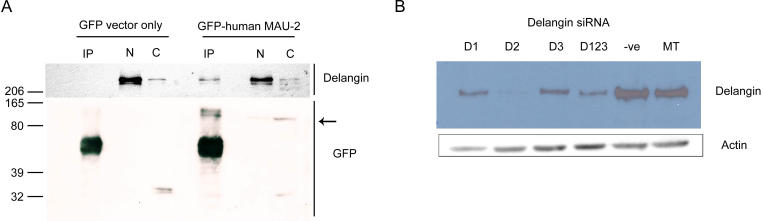
Co-Immunoprecipitation Studies Support Interaction between Delangin and Human MAU-2(A) Delangin co-immunoprecipitates with a GFP-human MAU-2 fusion protein. HeLa cells were transiently transfected with a GFP-human MAU-2 fusion protein construct (see
Materials and Methods) or, as a negative control, with the GFP vector on its own. Cells were fractionated into nuclear (N) and cytoplasmic (C) fractions, and aliquots of the nuclear fractions were used for immunoprecipitation with an anti-GFP antibody to generate immunoprecipitation fractions. Individual fractions were size fractionated by SDS-PAGE and immunoblotted, using antibodies against delangin (top panel) or against GFP (bottom panel) as described in
Materials and Methods. The immunoprecipitation fraction from immunoprecipitating the GFP-human MAU-2 fusion protein reveals a specific band at ˜100 kDa (arrow) that is not found in the negative control sample. This is the size expected for the fusion protein (˜70 kDa for human MAU-2 and ˜ 30 kDa for GFP). The upper panel shows that the delangin antibodies identify a band of ˜ 300 kDa that is co-precipitated in the GFP-human MAU-2 immunoprecipitation sample but not in the GFP vector-only control sample.
(B) Delangin siRNA. In order to validate the specificity of the monoclonal antibody to delangin, HeLa cells were transfected with siRNA oligonucleotides designed to knock down delangin using individual oligonucleotides D1–D3 (see
Materials and Methods) or all three combined, D123. D2 produced the most effective delangin knockdown. The same band that was recognized by the antibody in the immunoprecipitation fraction (see A) was knocked down by ˜ 90% in cells transfected with the D2 siRNA oligonucleotide, when referenced against negative (−ve) and mock-transfected HeLa cell (MT) controls.